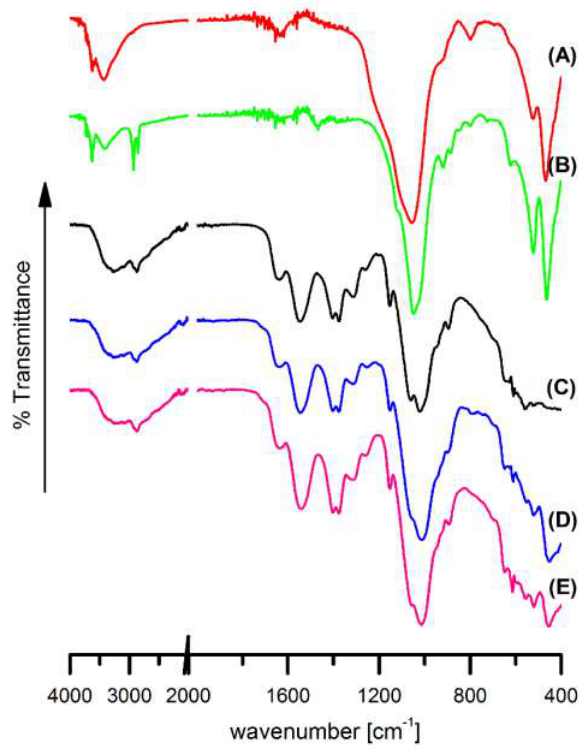
Figure 3. FTIR spectra of montmorillonite ( A ), Cloisite 30B ( B ) powders and PA6/Ch ( C ), PA6/Ch/MMT ( D ), and PA6/Ch/C30B ( E ) films.